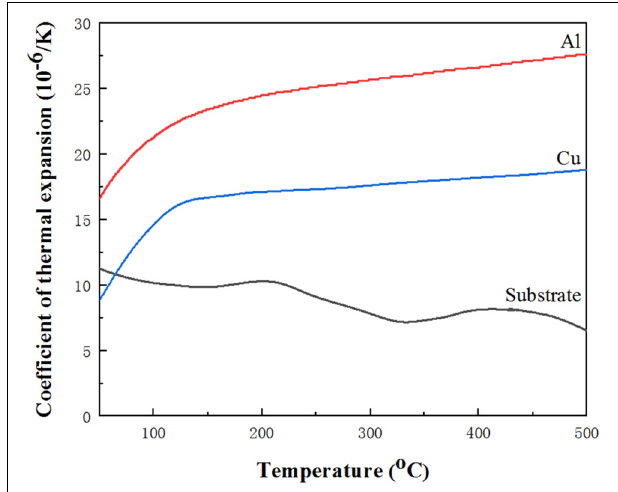
FIGURE 4 | Thermal expansion coefficients of substrate and bond coats.